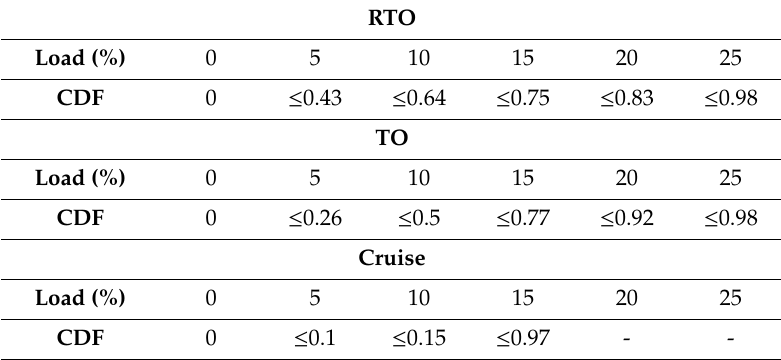
Table 4. Generator